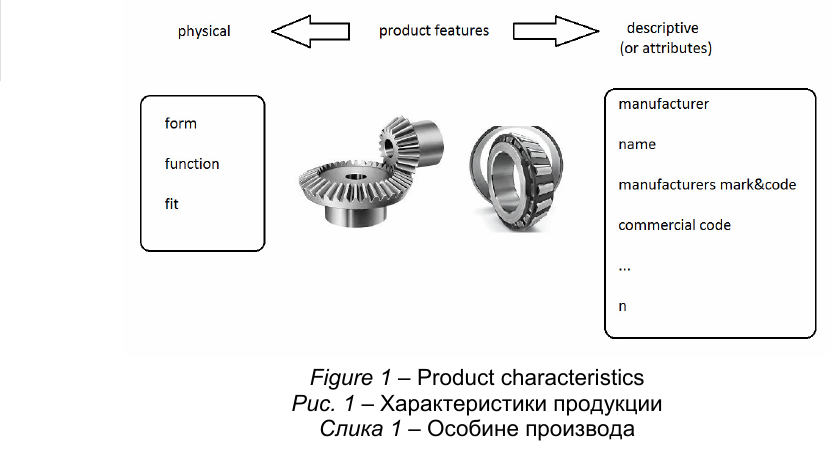
Figure 1 – Product characteristics Рис . 1 – Характеристики продукции Слика 1 – Особине